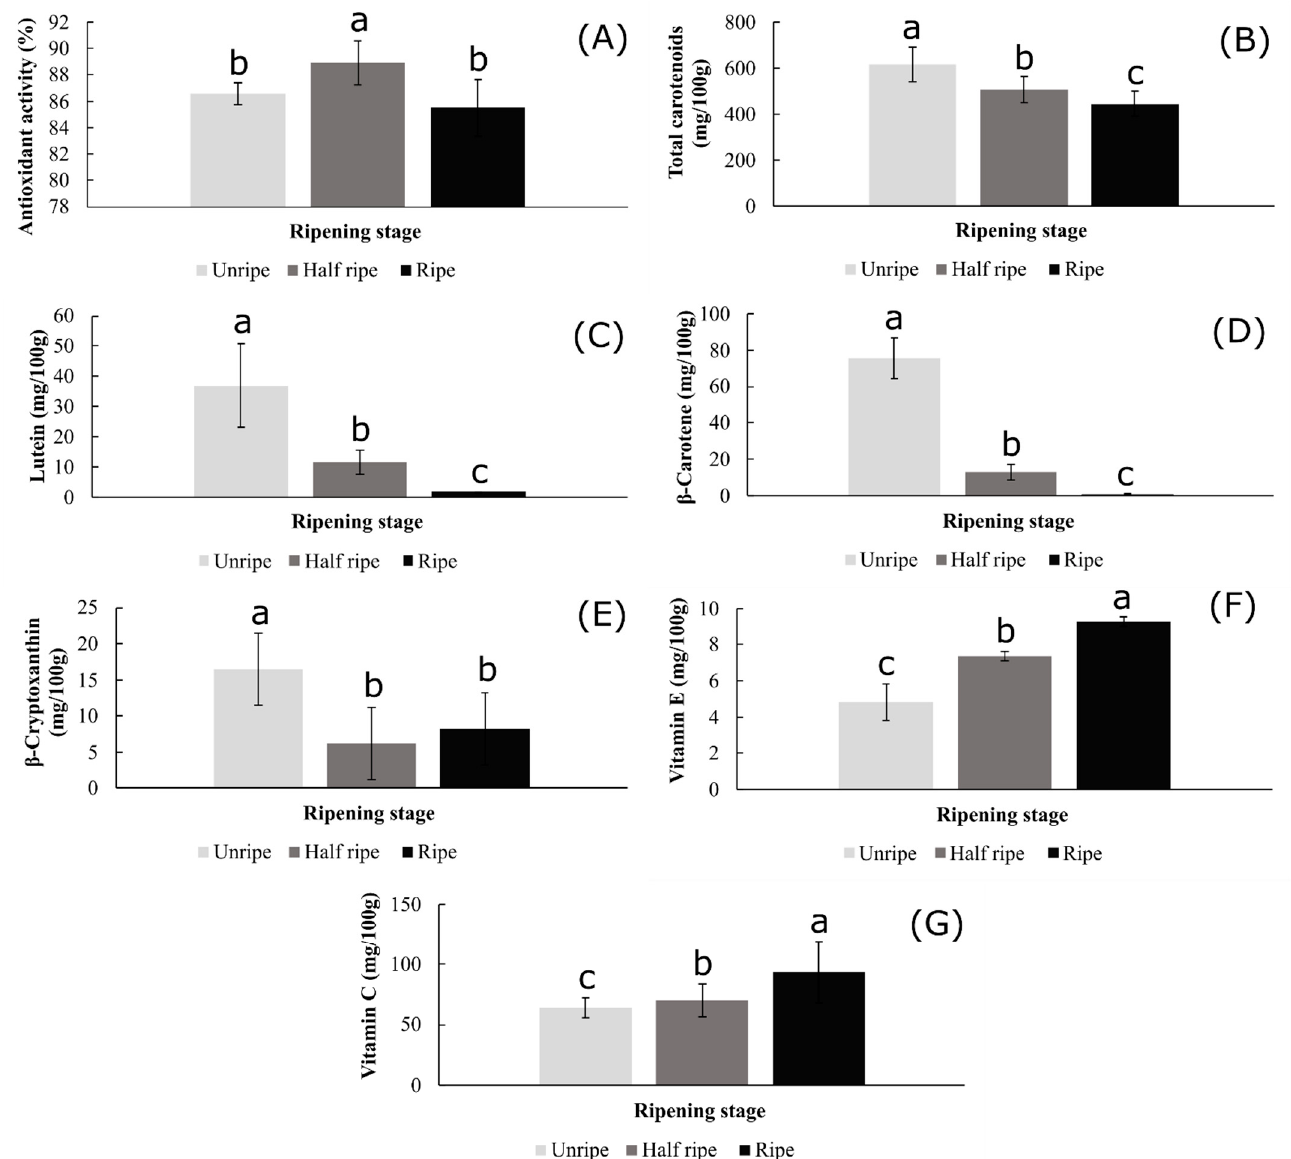
Figure 2. Determination of ( A ) antioxidant activity, ( B ) total carotenoids, ( C ) lutein, ( D ) β -carotene, ( E ) β -cryptoxanthin, ( F ) Vitamin E ( α -tocopherol) and ( G ) Vitamin C (ascorbic acid) by ripening stage. Data are presented as means (mg/100 g of dry mass) and error bars represent standard deviation (number of replications = 3). Different letters indicate statistically significant differences using least significant difference (LSD) test at p ≤ 0.05.